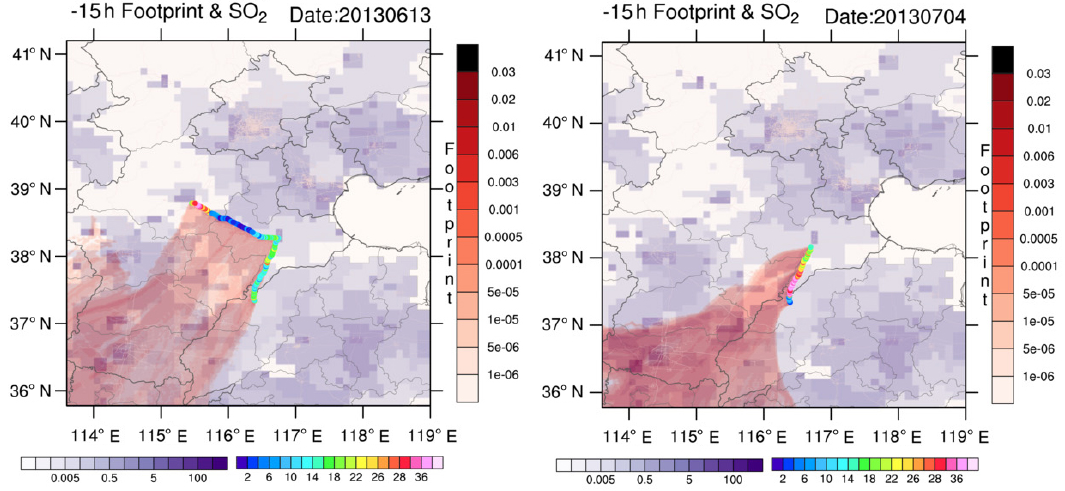
Figure 9. The back trajectories of observed air masses in the central NCP on 13 June and 4